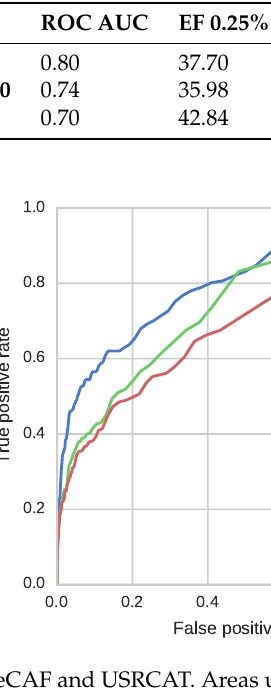
Figure 5. ROC curves for DeCAF and USRCAT. Areas under the curves are equal 0.80, 0.74, and 0.70 for DeCAF, USRCAT_1 and USRCAT_30,